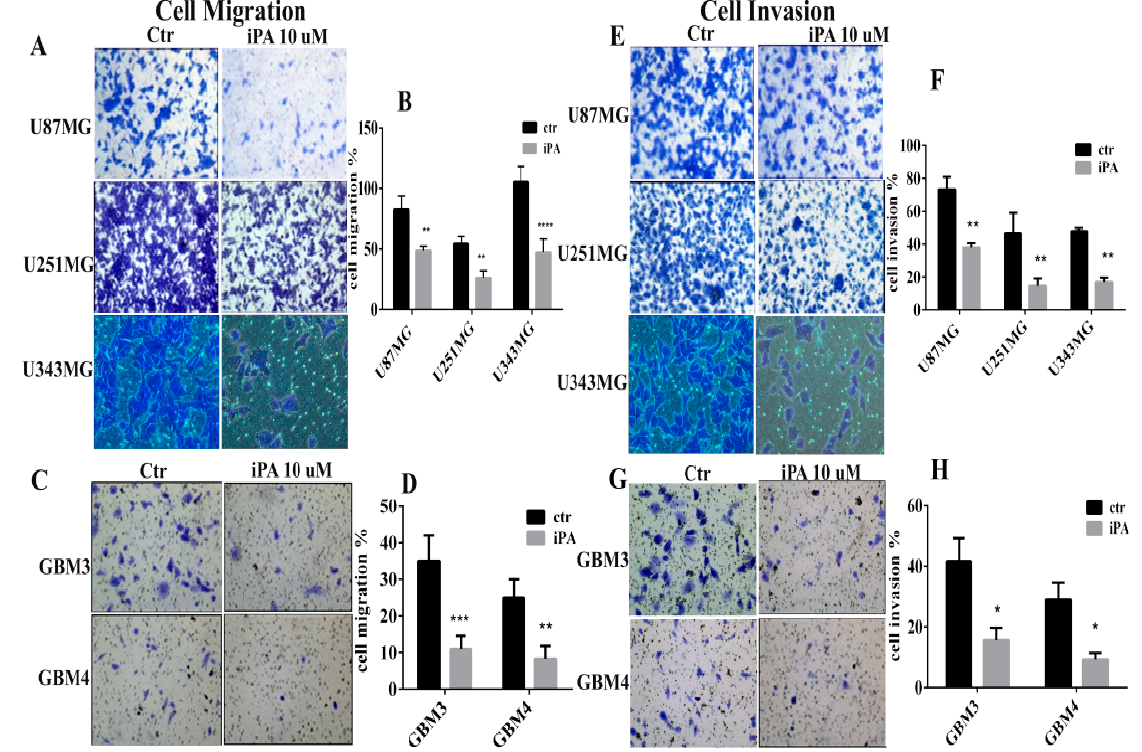
Figure 3. Inhibitory effect of iPA on cell motility in vitro. Transwell assays were used to measure the effect of iPA on cell migration and invasion of GBM cells. ( A ) Representative images showing the reduction of cell migration of cell lines U87MG, U251MG, and U343MG treated with iPA at 18 h, stained with crystal violet. ( B ) Diagram showing the quantitative analysis of U87MG, U251MG, and U343MG cells migration at 18 h. ( C ) Representative images showing the reduction of cell migration GBM primary cell line (GBM3-4) treated with iPA at 18 h, stained with crystal violet. ( D ) Diagram showing the quantitative analysis of GBM primary cell line (GBM3-4) migration at 18 h. ( E ) Representative images showing the reduction of cell invasion of cell lines U87MG, U251MG, and U343MG treated with iPA at 18 h, stained with crystal violet. ( F ) Diagram showing the quantitative analysis of U87MG, U251MG, and U343MG cells invasion at 18 h. ( G ) Representative images showing the reduction in cell invasion of GBM primary cell line (GBM3-4) treated with iPA at 18 h, stained with crystal violet. ( H ) Diagram showing the quantitative analysis of invasion of GBM primary cell line (GBM3-4) at 18 h. The images are shown at 10× magnification. Results are expressed as the mean ± SD of four independent experiments conducted in triplicate. (ANOVA, * p < 0.05, ** p < 0.01, *** p < 0.001, **** p < 0.0001).